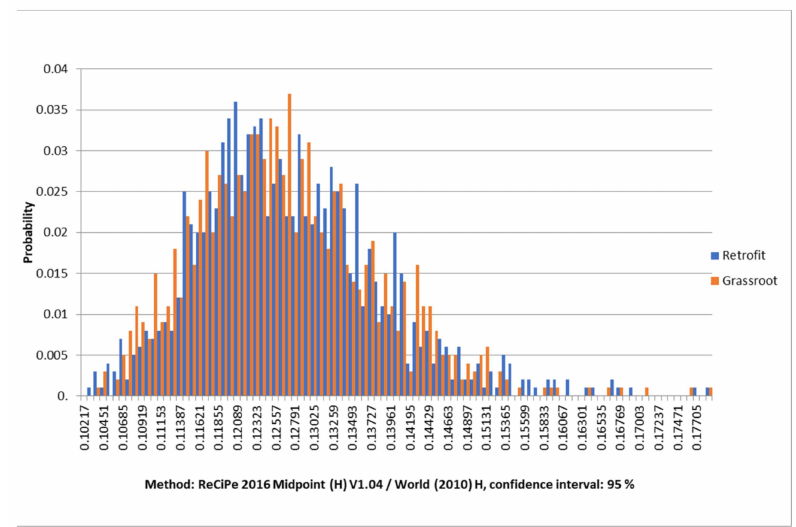
Figure 11. Distribution of probability index of